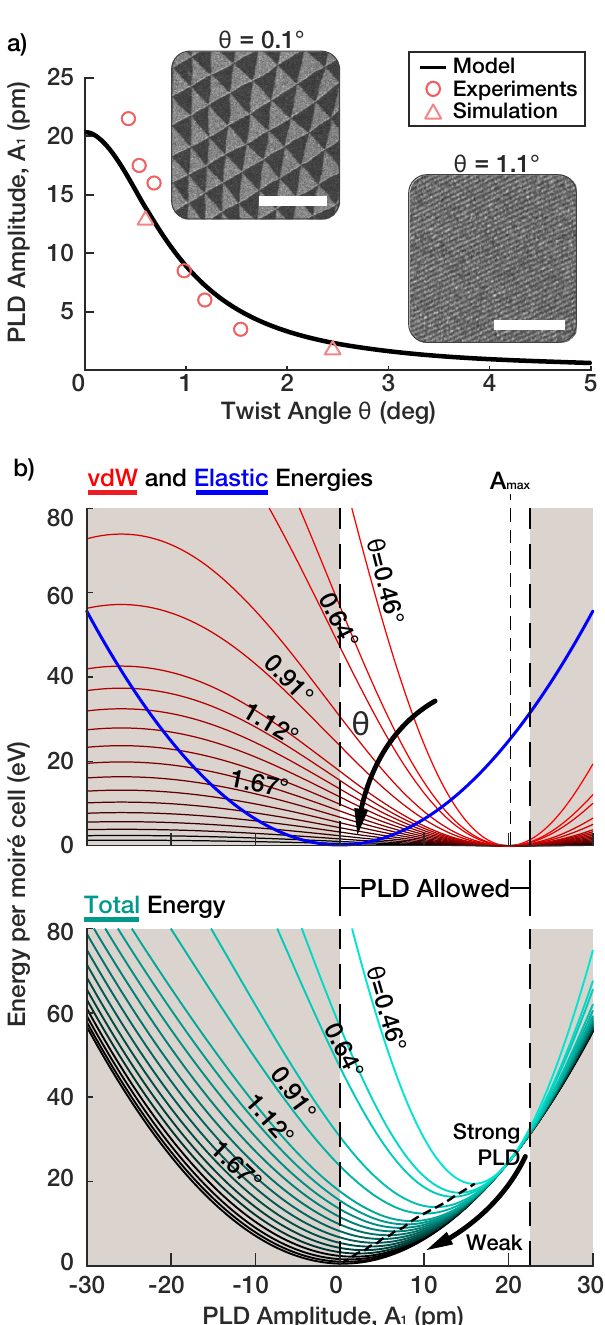
Fig. 3 | Energy and amplitude of PLDs in twisted bilayer graphene (TBG). a Torsional PLD model predicts the PLD amplitude ( A 1 ) of TBG vs twist angle ( θ ) followsLorentzian.ExtractedtorsionalPLDamplitude( A 1 )fromexperimentalSAED (red circles) and computationally relaxed (red triangles) matches well with the Lorentzian model.Scale bars are 500 nm (0.1 ∘ ) and 150 nm (1.1 ∘ ). b Top panel: V vdW V V El V vdw (red) and El (blue) of TBG with torsional PLD. The lighter region denotes geometrically-allowedPLDamplitude(0 ≤ A 1 ≤ 22.6pm).Notethattheelasticcostof torsional PLD is twist angle independent, and V vdW V vdW is proportional to θ − 2 and has a minimum at A 1 =20.35pm. Bottom panel: total energy landscape ( V vdW + V El ) ( V vdW + V El ) of TBG with torsional PLD. θ dependence of V vdW shifts the total energy minimum to stronger